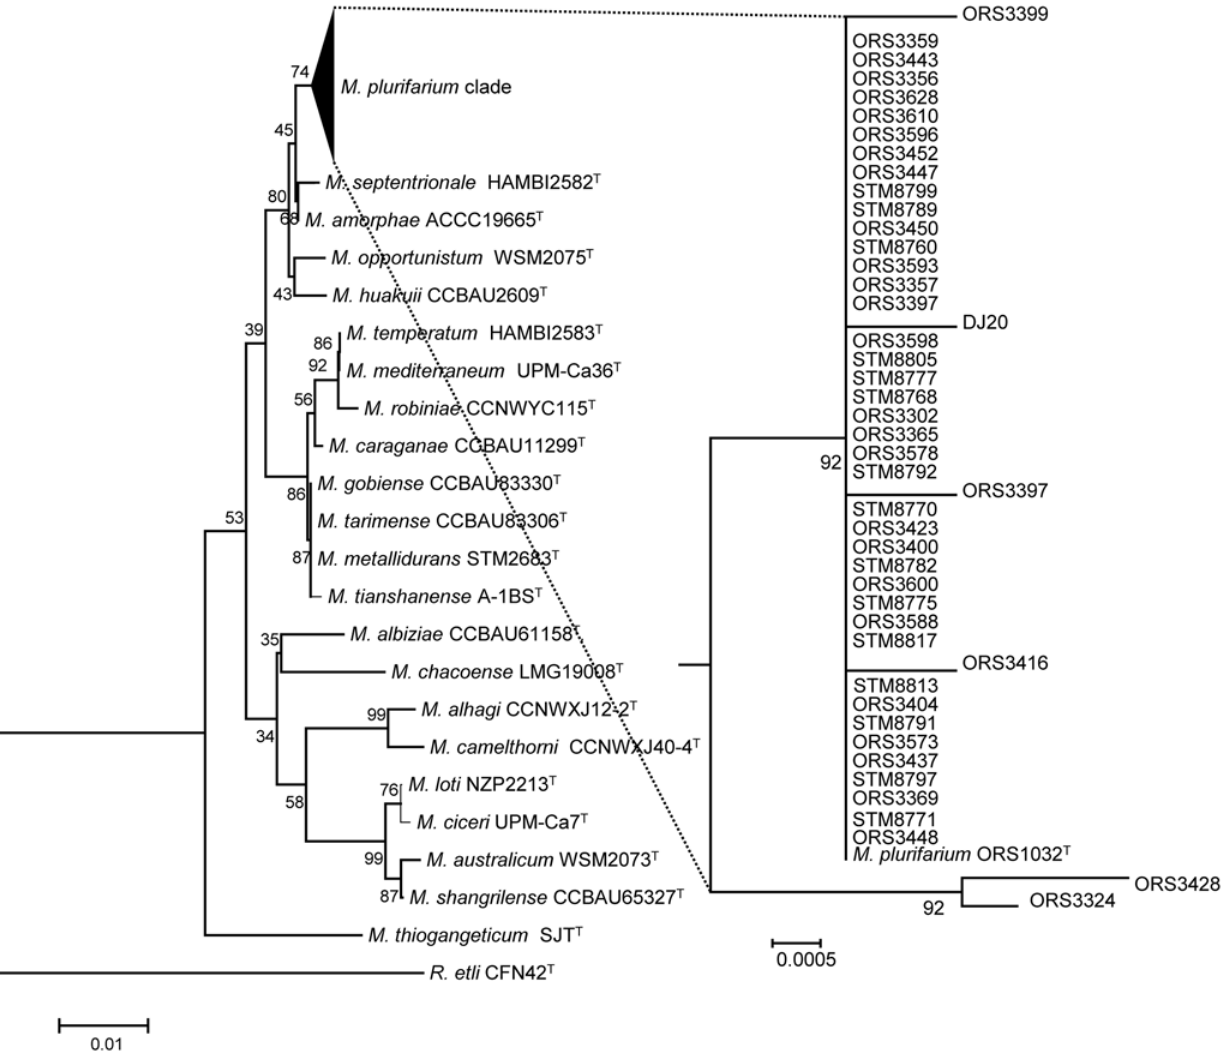
Fig 2. Phylogeny of the 16S rRNA marker of the Mesorhizobium collection, built by neighbor joining from a distance matrix corrected by the Kimura-2 method. The scale bar indicates the number of substitutions per site. Numbers at tree nodes indicate % of bootstrap